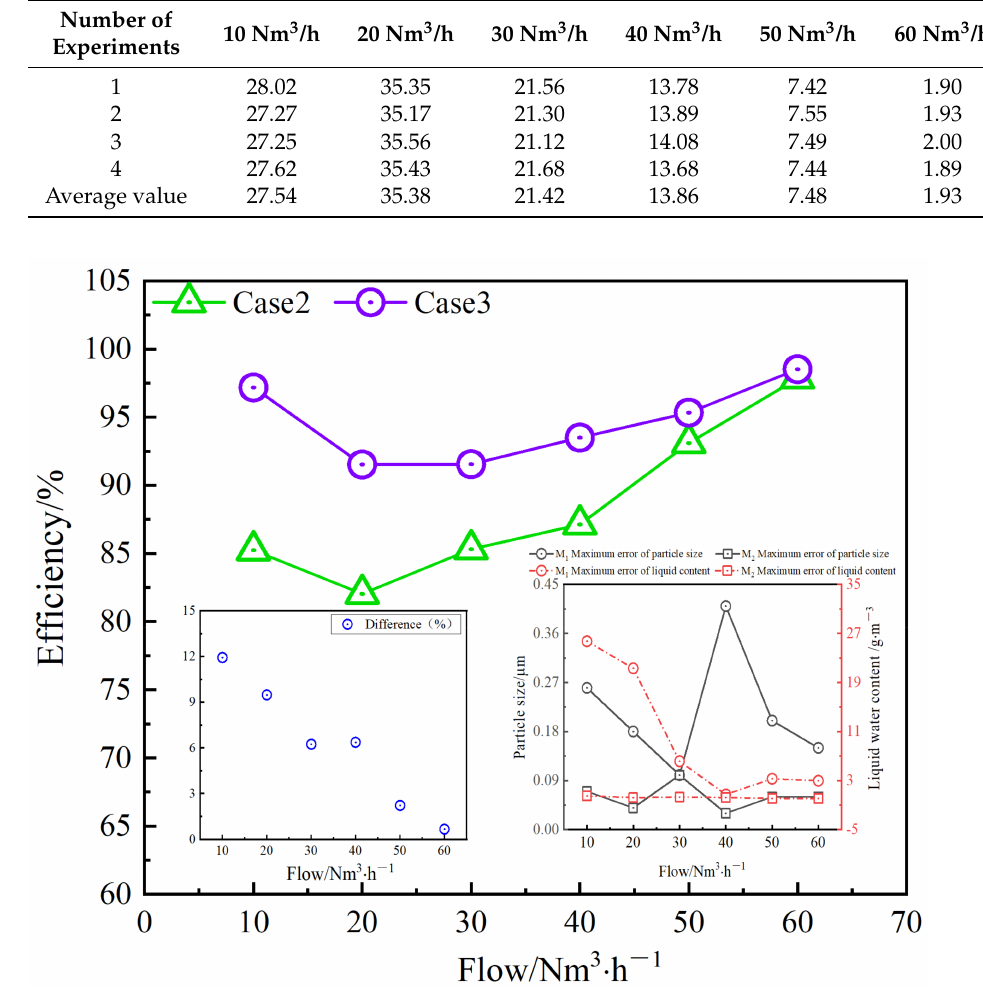
Table 14. Liquid content in Case 3 at M 2 (g/m 3 ).